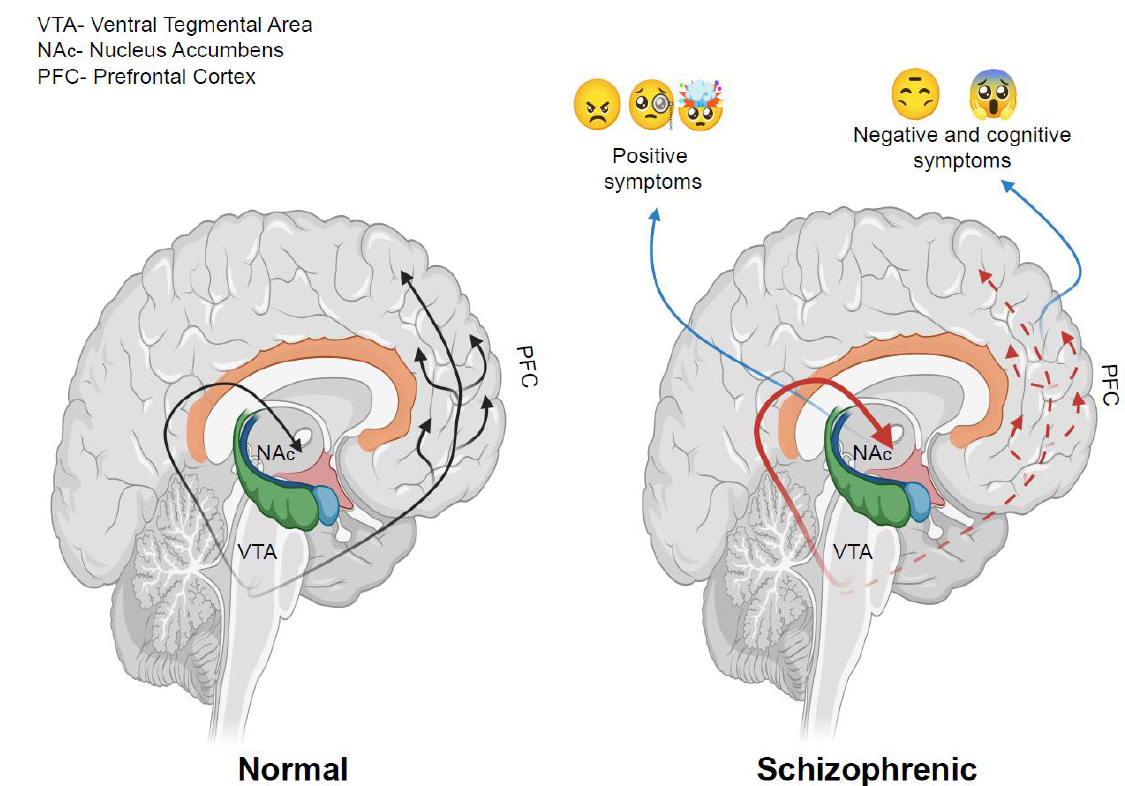
Figure 3. Roles of two different brain dopaminergic pathways in schizophrenia. Over-activation of the mesolimbic DAergic system is believed to correlate with the positive symptoms of schizophrenia. Hypofunctioning of the mesocortical DAergic pathway, which is associated with cognitive function, e.g., working memory, is believed to correlate with the negative symptoms of schizophrenia. NAc, nucleus accumbens; PFC, prefrontal cortex; VTA, ventral tegmental area. Figures created with https://biorender.com/ (accessed on 12 April 2021).